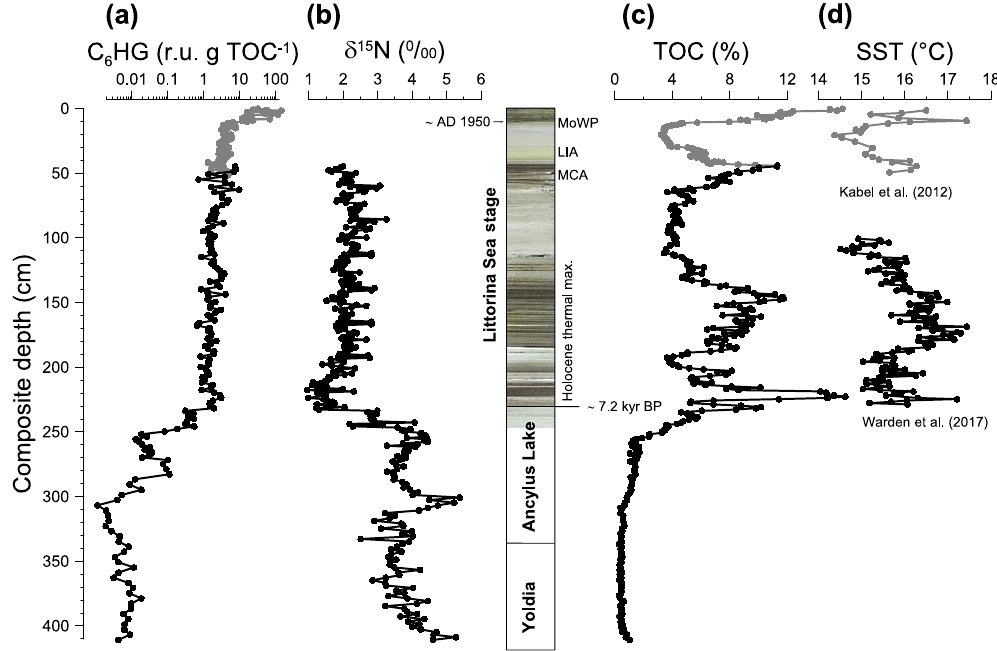
Figure 3. Proxy records of the Baltic Sea cores on a composite depth scale aligned with core photos showing the lamination of the sediments of the post-Ancylus Lake stage. (a) The abundance of the HGs (r . u . gTOC − 1 ) on a log scale; (b) δ 15 N (‰); (c) TOC content (%) partly derived from Warden et al. (2017); and (d) TEX 86 -derived summer sea surface temperatures (SSTs) from Kabel et al. (2012) and Warden et al. (2017). Data points derived from the MUC P435-1-4 core are in gray, and those from the GC 303600 core are in black. The stratigraphy is based on age models published elsewhere (Kabel et al., 2012; Warden et al., 2017), and for the deeper part of the GC 303600 core, it is based on unpublished data on diatom assemblages. The TEX 86 data of Kabel et al. (2012) were measured on a different core (MUC 303600) obtained from the same site, which was correlated to the MUC P435-1-4 core based on the TOC profiles (Fig. S1 in the Supplement). Note that phases characterized by the deposition of laminated sediments are the periods during the Holocene when the bottom waters of the Baltic Sea were